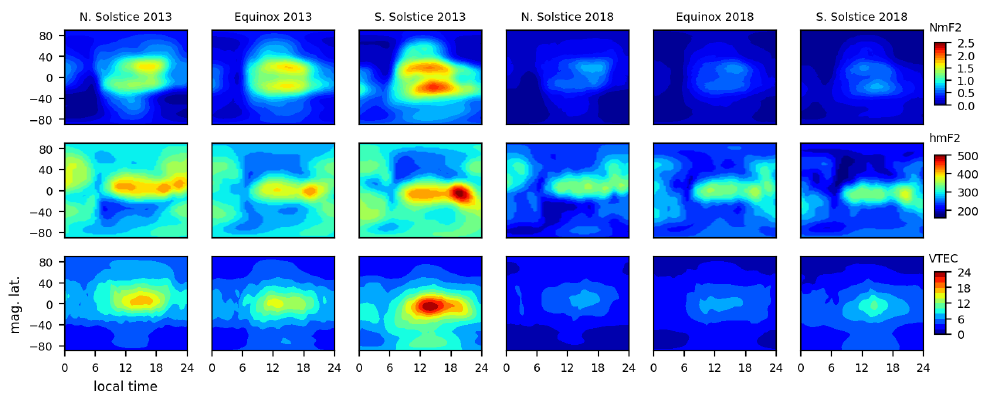
Figure 1. General patterns of the estimated values of NmF2 (10 12 el/m 3 ), hmF2 (km) and topside VTEC (10 16 el/m 2 ). The days of 2013 are related to days of year (DOY) 172, 264 and 356 for the Northern solstice, equinox and Southern solstice, respectively. DOYs of 2018 are related to 180, 264 and 359 for the Northern solstice, equinox and Southern solstice, respectively. These are the closest DOYs to the seasons of interest with actual COSMIC